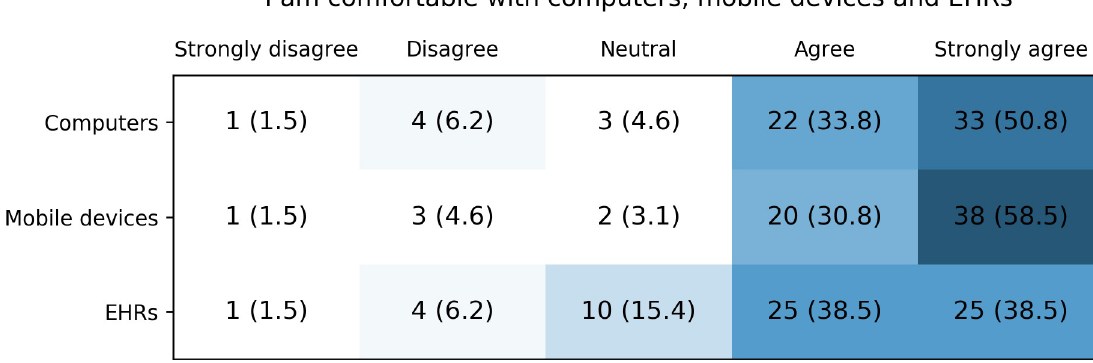
Fig 6. Healthcare provider’s self-reported comfortableness with computers, mobile devices and electronic health records (EHRs).